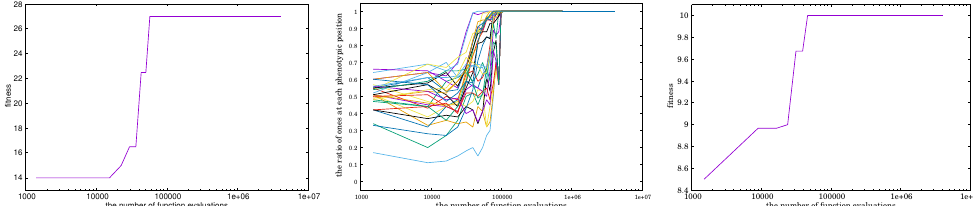
( d ) Fitness convergence curve for for HTRAP ( (cid:96) = 27) when using the EDT with P =100 and T c = (cid:100) (cid:96) /2 (cid:101) .